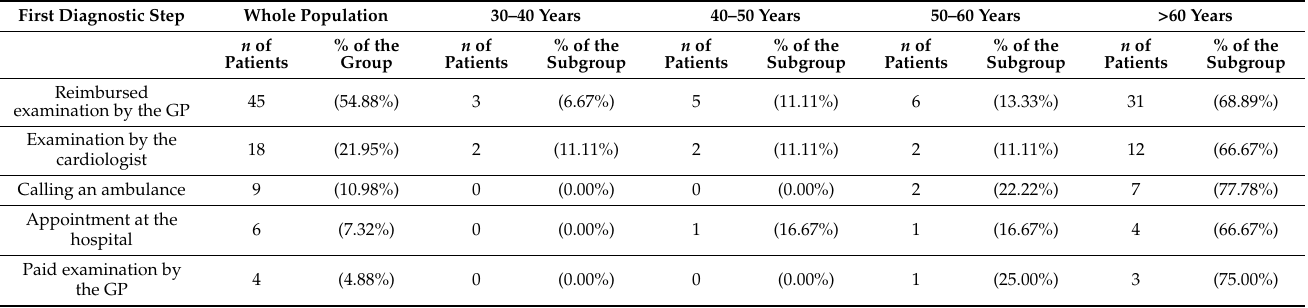
Table 3. The first step in the diagnostic process. Data are additionally stratified by age and pre- sented as the number of patients who declared a particular step as the first during the diagnostic process and the percentage of the whole population or a particular subgroup. Abbreviations: GP, general